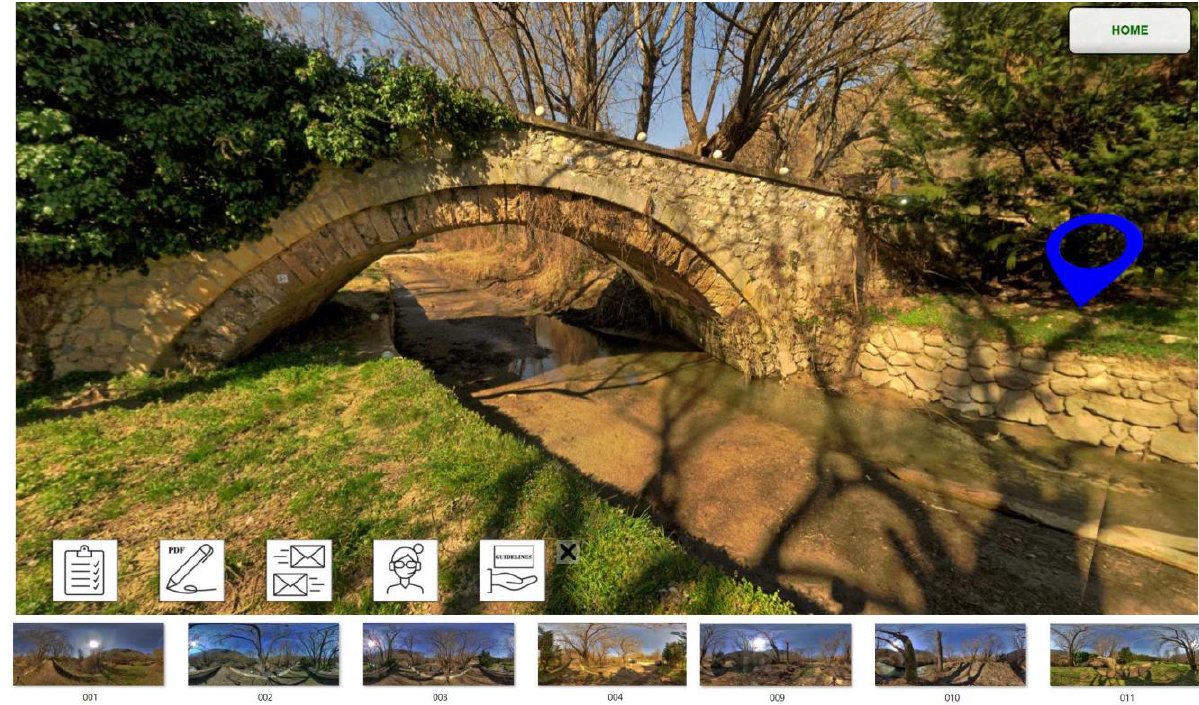
Figure 4. Informative Virtual Tour of the bridge.